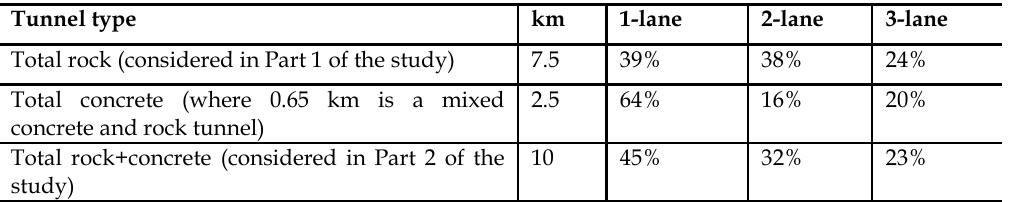
Table 1. Lengths of the tunnel parts of Norra Länken examined in this study (Vägverket, 2009) Tunnel type km 1-lane 2-lane 3-lane Total rock (considered in Part 1 of the study) 7.5 39% 38% 24% Total concrete (where 0.65 km is a mixed 2.5 64% 16% concrete and rock tunnel)